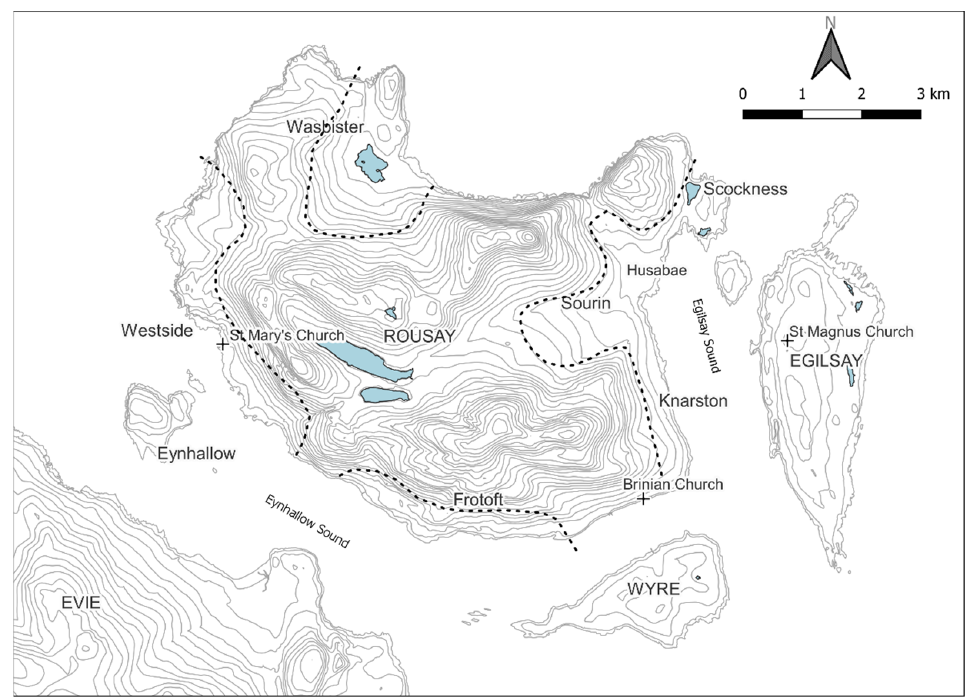
Figure 2. Map of united parishes of Rousay and Egilsay illustrating locations of the parish churches, the approximate extents of main districts and islands, as well the physical topography (Contour spacing 10m) and part of the adjacent parish of Evie. OS Terrain 50 Contours © Crown copyright and database rights 2021 Ordnance Survey (100025252).